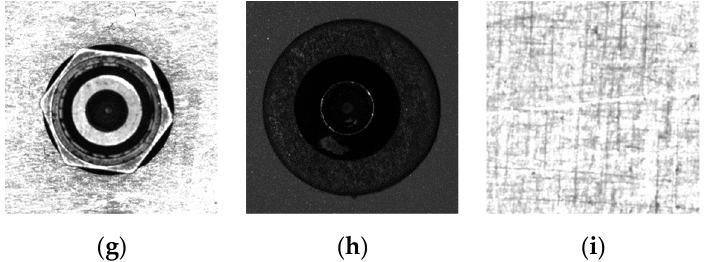
Figure 4. Categories of referencing elements. ( a ) drill; ( b ) countersink; ( c ) rivet; ( d ) protruding rivet; ( e ) temporary fastener 1; ( f ) Temporary fastener 2; ( g ) hexagonal; ( h ) screw; and ( i ) background.